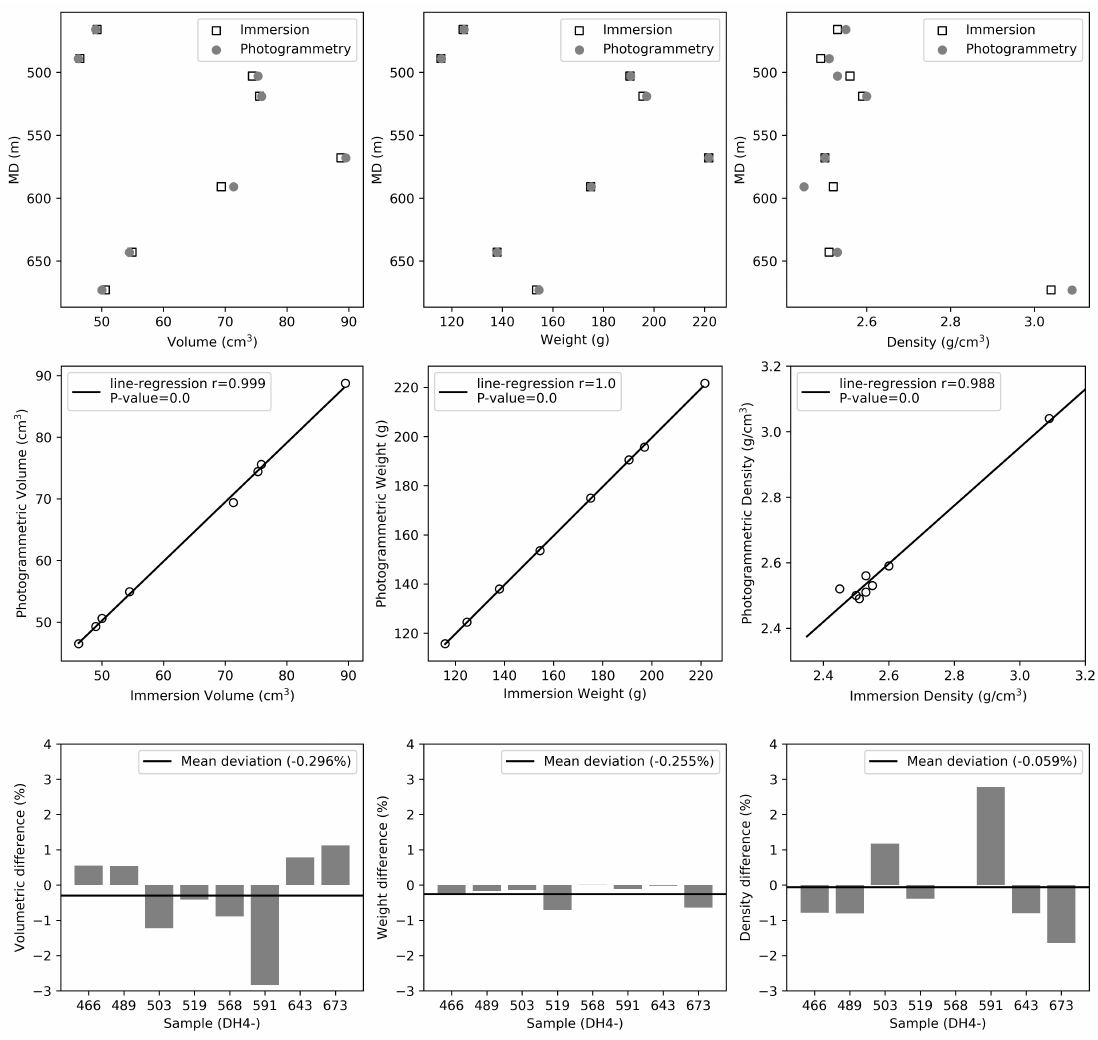
Figure 6. Volumes, masses, and bulk densities as derived from the immersion in fluid and photogrammetric